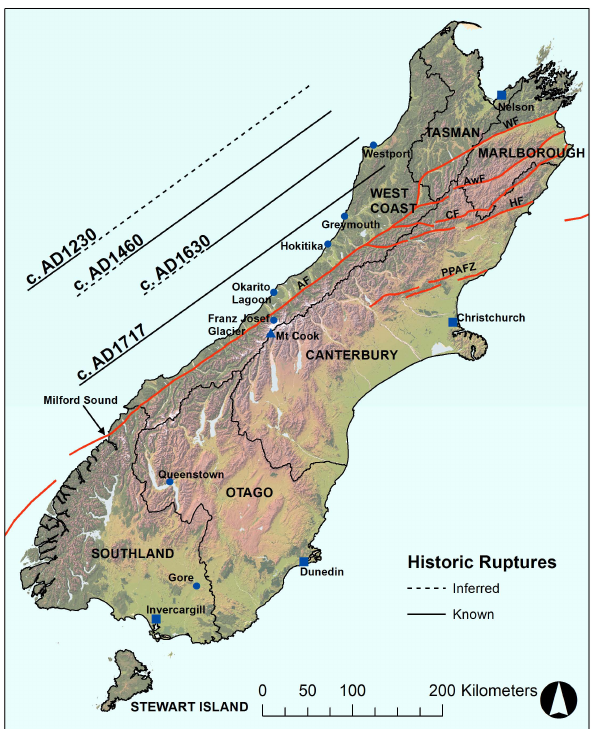
Fig. 3. Known and inferred rupture lengths of the last four Alpine Fault